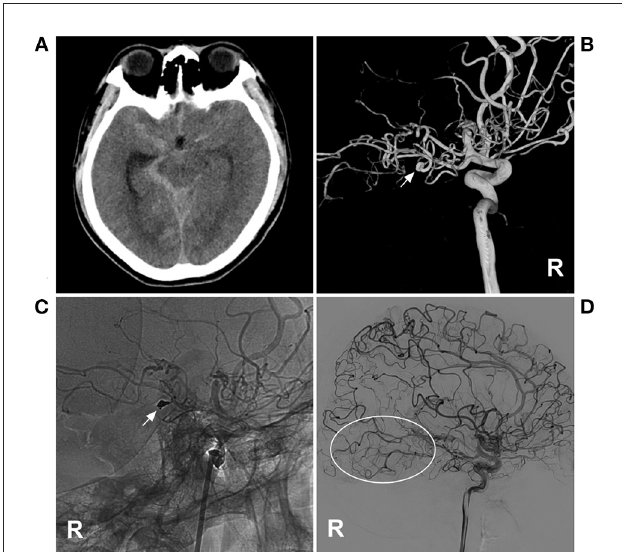
FIGURE2 PAO of the PCA aneurysm in case 5 in Table 1. (A) DSA of the right carotid artery showed that the extracranial ICA was thin, and the intracranial ICA was MMD. (B) DSA of the right vertebral artery showed an aneurysm located on the P2–3 segment of the right PCA (arrow). (C) Unsubtracted DSA showed PAO of the P2–3 segment of the PCA by coiling (arrow). (D) DSA showed that the aneurysm (arrow) could be seen by reflux from the collateral circulation in the late artery phase of the arterial angiogram. DSA, digital subtracted angiography; ICA, internal carotid artery; MMD, moyamoya disease; PAO, parent artery occlusion; PCA, posterior cerebral artery; R,